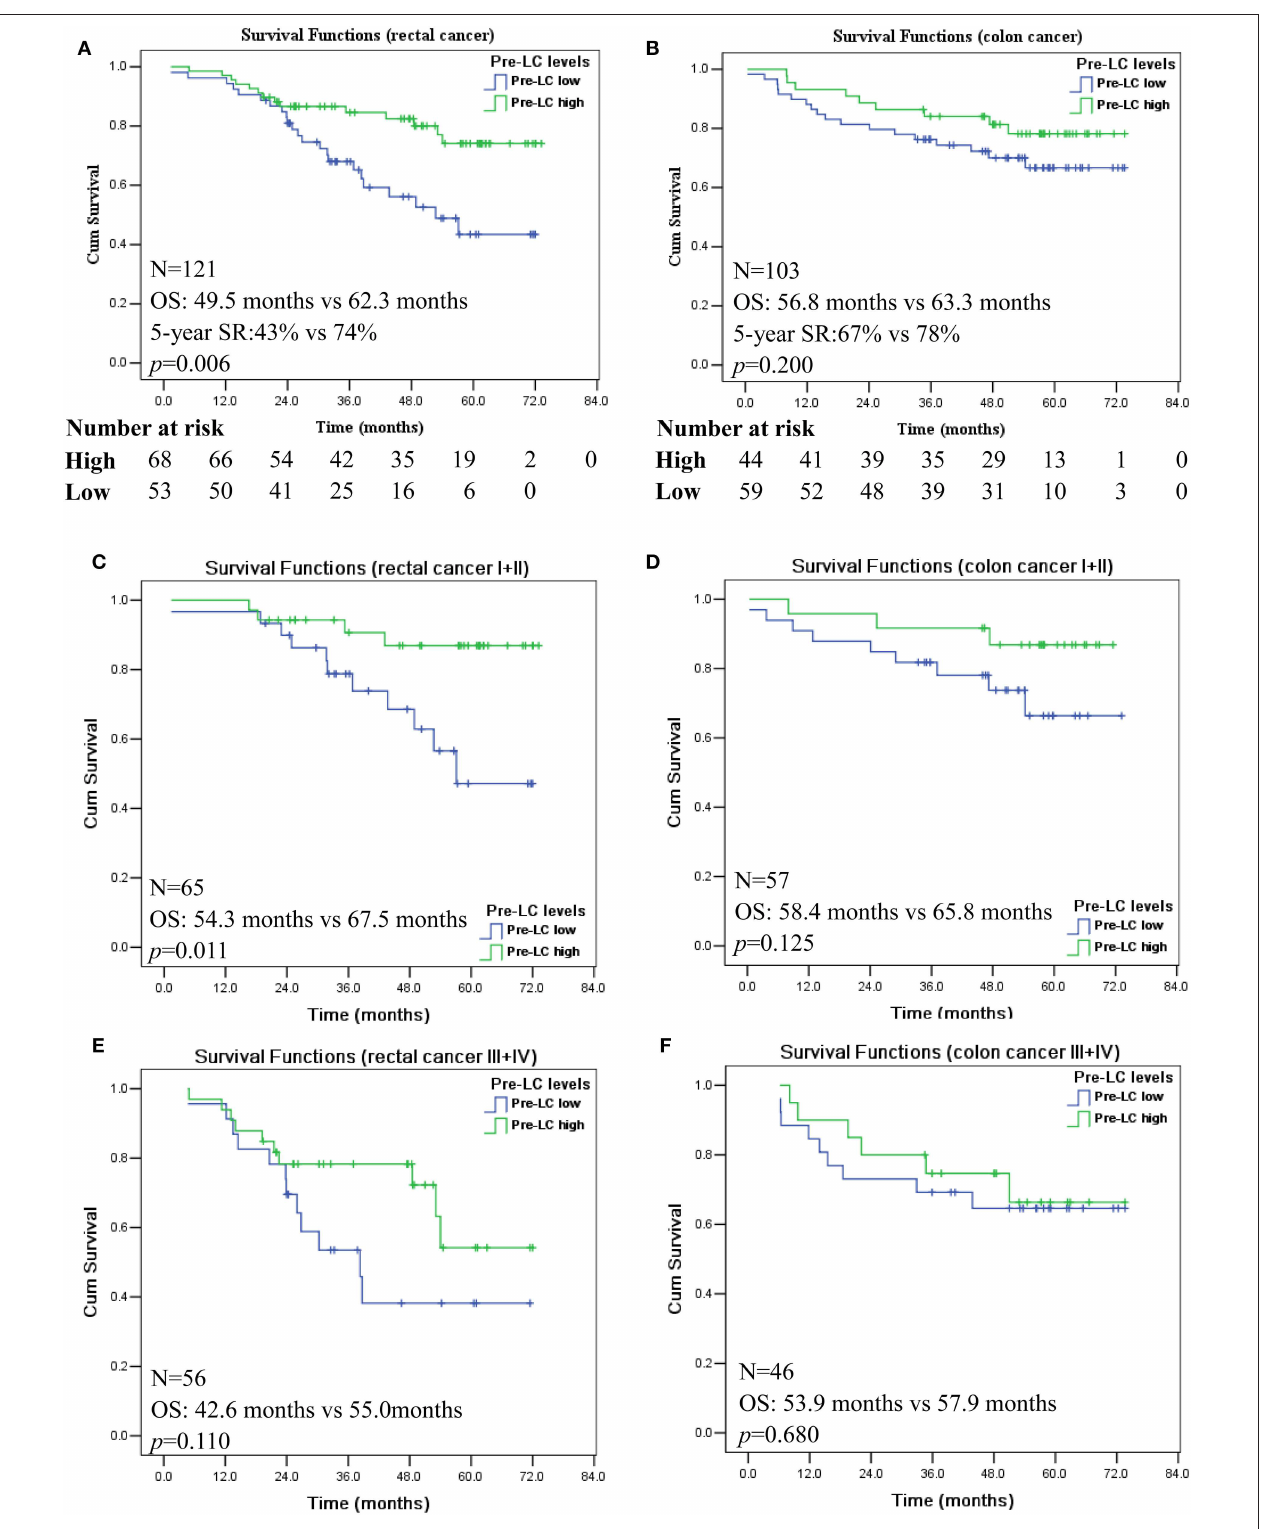
FIGURE 3 | Kaplan-Meier survival analysis of the high and low levels of pre-operation peripheral lymphocyte count in rectal and colon cancer patients with AJCC I + II and III + IV disease stages. Comparison of overall survival between pre-LC high and pre-LC low among patients with rectal cancer (A) ; colon cancer (B) ; rectal cancer patients with disease stage I + II (C) and III + IV (E) ; colon cancer patients with disease stage I + II (D) and III + IV (F) .